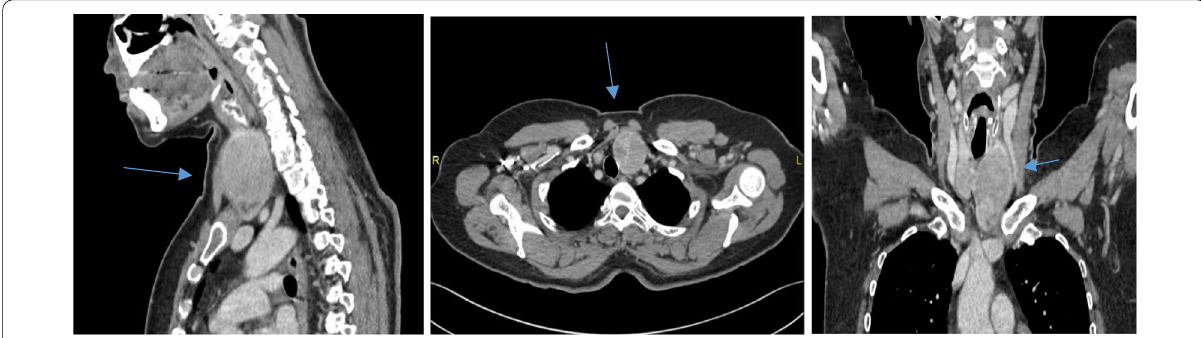
Fig. 1 CT scan of neck and thorax demonstrated that there were several nodules inside the thyroid nodule with the largest nodule measuring 4.4 3.4 6.4 cm (AP W CC) in the left thyroid × × × ×